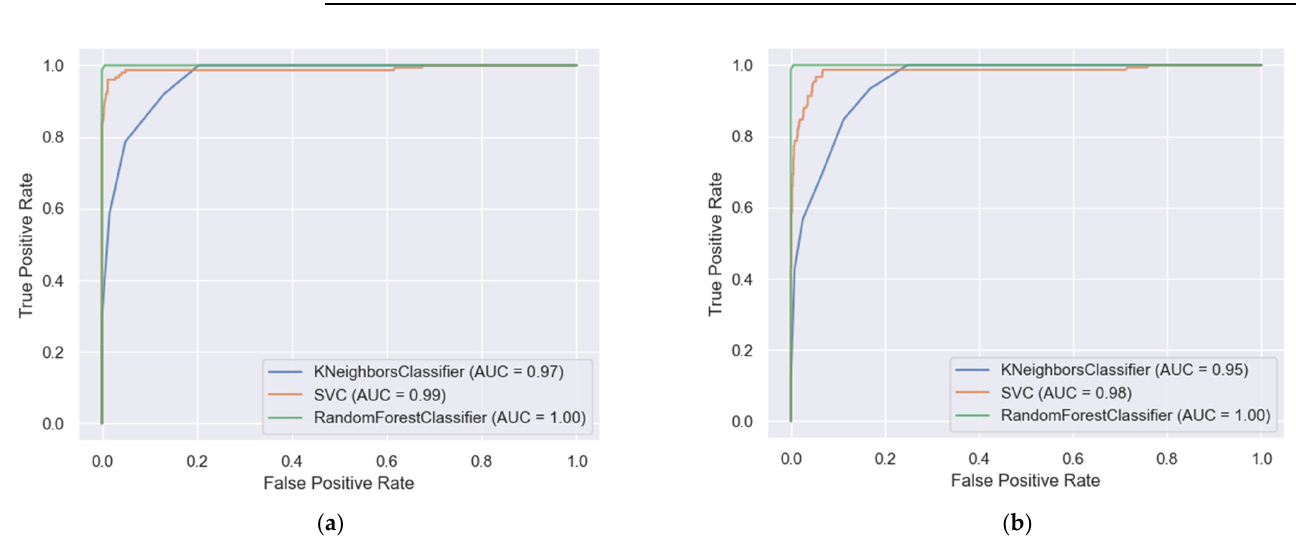
Figure 10. Combined ROC curve for the proposed classifiers. ( a ) applying stator current signal I 2 ;